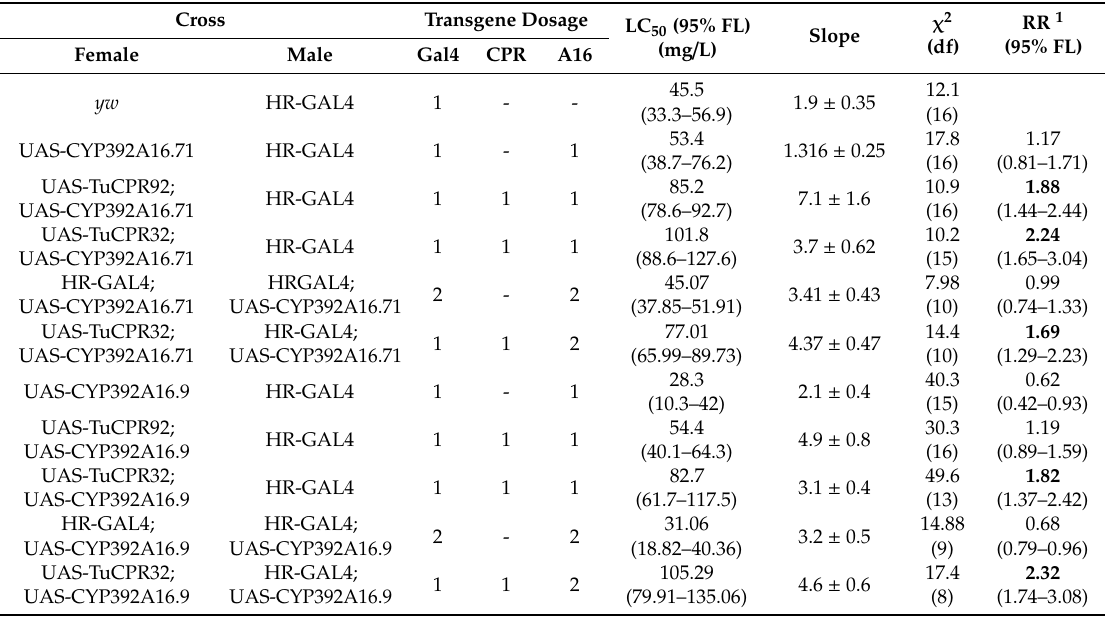
Table 2. Abamectin toxicity bioassay responses of transgenic flies expressing CYP392A16 coupled with endogenous Drosophila CPR or along TuCPR, with di ff erent transgene copy number (dosage) combinations, compared to the control cross yw × HR-GAL4 of the same genetic